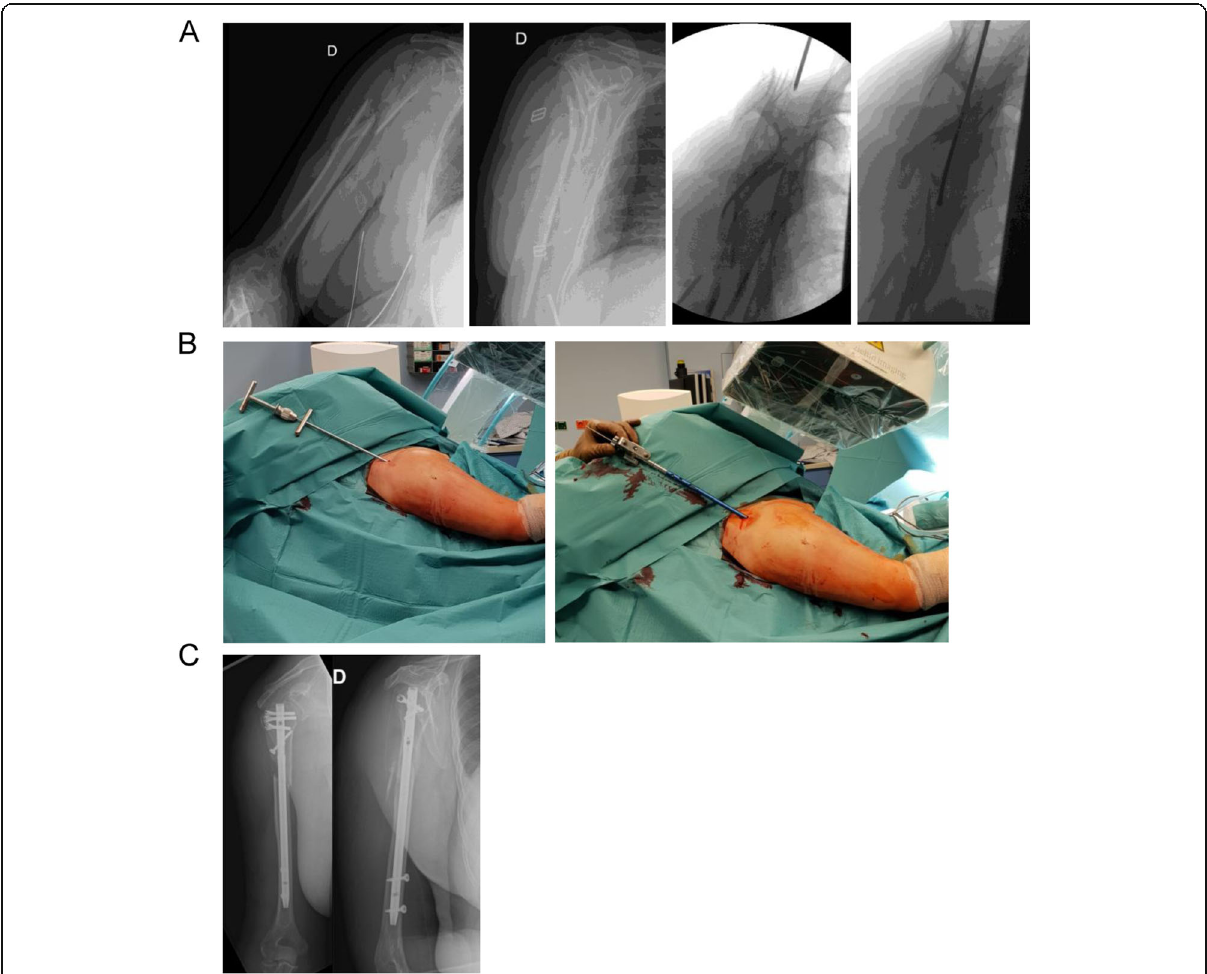
Fig. 4 Female patient, 64 years. Metaphyseal fracture of the proximal Humerus. Rotating the image intensifier allows for ap and tangential view of the proximal humerus and determination of the entry point and direction ( 2a ). Intraoperative view of the insertion site ( 2b ) and immediate postoperative control ( 2c